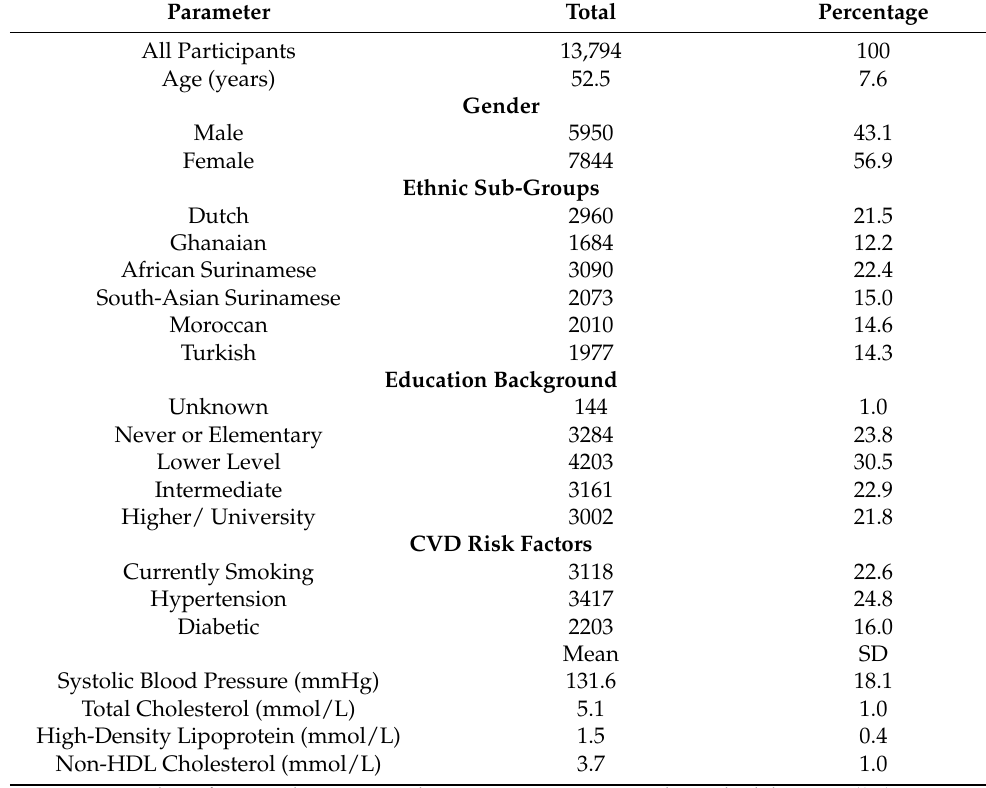
Table 1. Demographic characteristics of the study population.